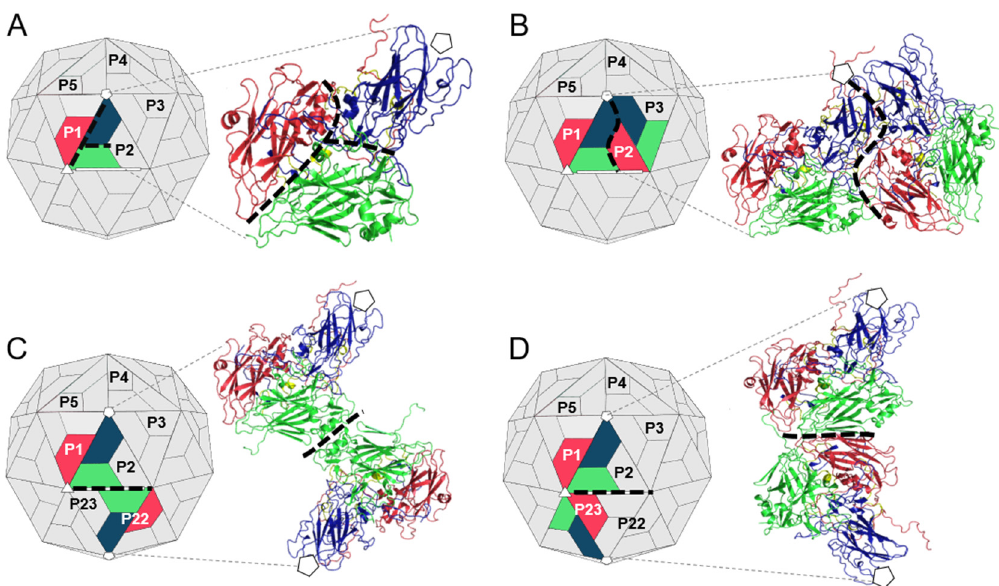
Figure 2. TMEV GDVII capsid subcomplexes for subunit interface hotspot and residue–residue interaction prediction. The respective subcomplexes were extracted from the biological assembly of TMEV GDVII in PyMOL. ( A ) The intraprotomer complex, consisting of a single protomer of the capsid. ( B ) The interprotomer complex, comprising two adjacent protomers within a pentamer. ( C ) The first complex of the interpentamer interface, consisting of two opposing protomers from two adjacent pentamers. ( D ) The second complex of the interpentamer interface, consisting of two adjacent protomers from two adjacent pentamers. Capsid proteins: VP1 (blue); VP2 (green); VP3 (red); and VP4 (yellow). The intraprotomer, interprotomer and interpentamer interfaces are denoted by black dashed lines. The five-fold, three-fold and two-fold axes are indicated by white pentagons, triangles and rectangles, respectively.